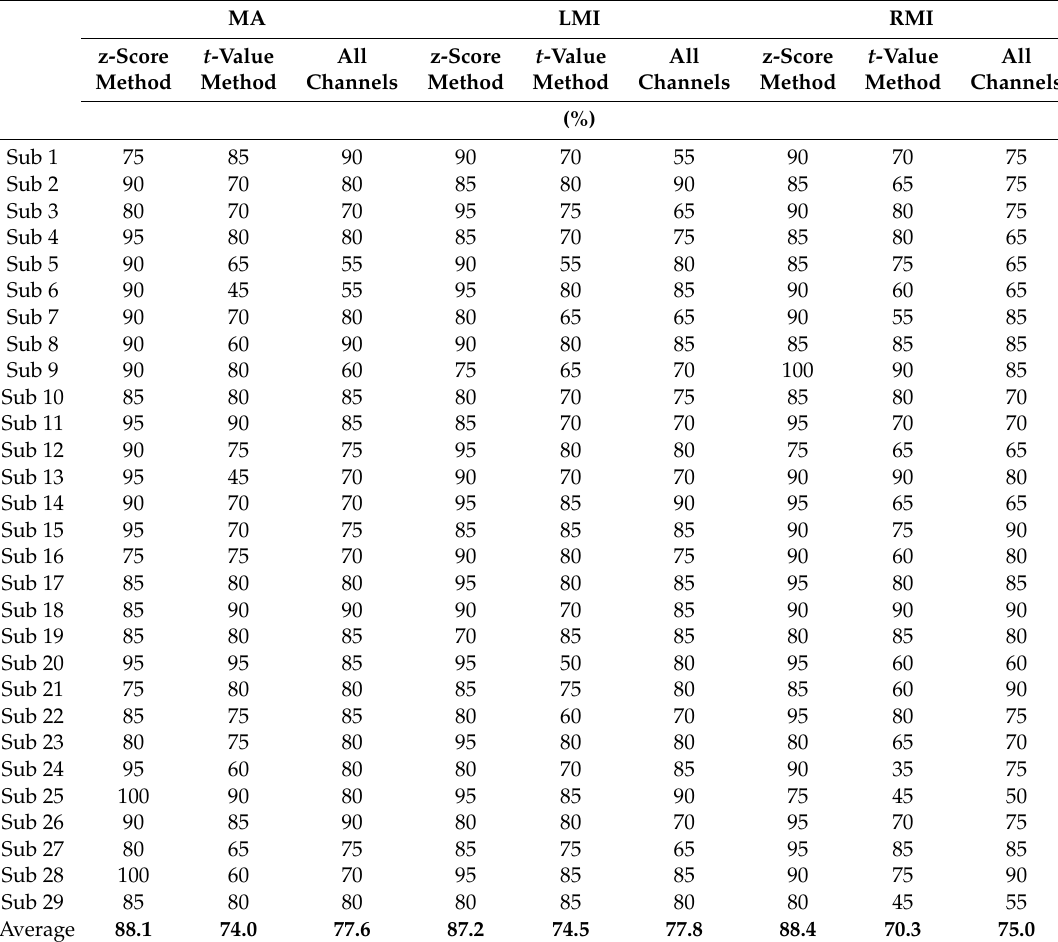
Table 1. Subject-wise classification accuracies by using the z-score method, t -value method, and all channels’ data for MA, LMI, and RMI tasks.